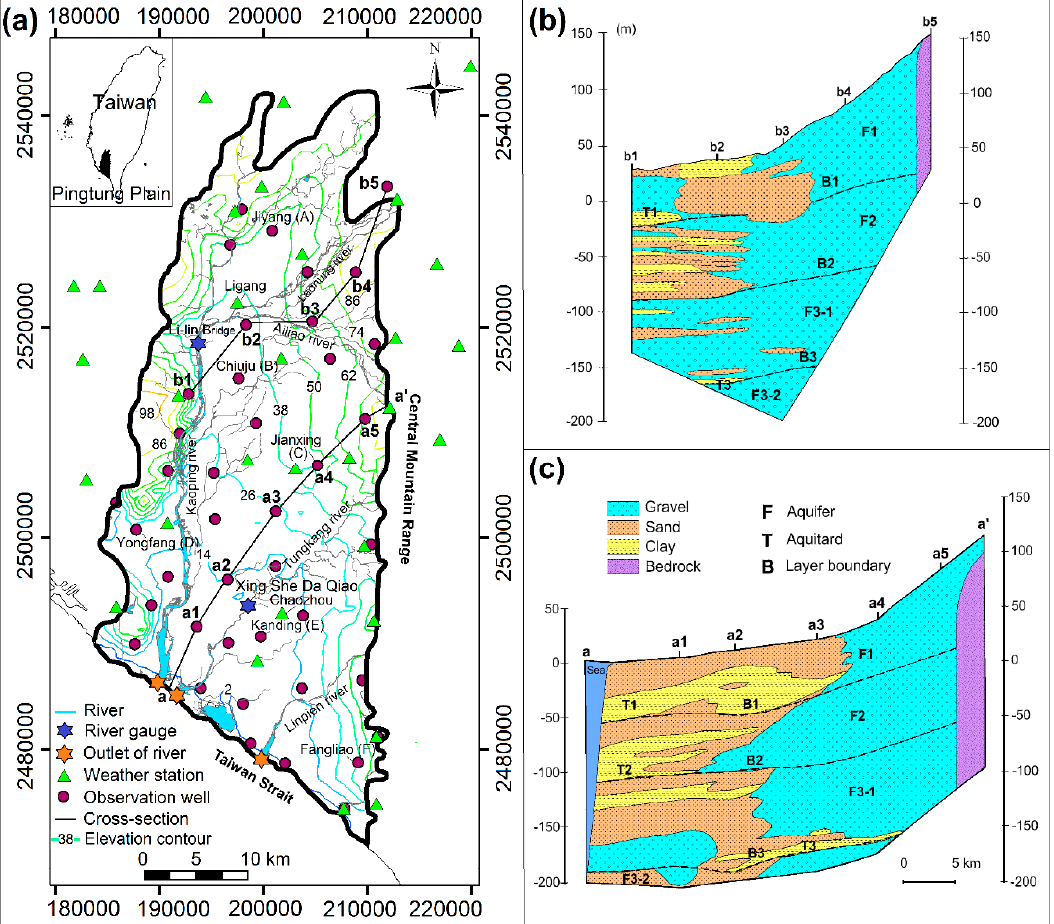
Figure 1. The study area and the selected hydrogeological profiles: ( a ) the Pingtung Plain groundwater basin (PPGB) and the monitoring stations for surface water and groundwater, ( b ) the geological profile for cross-section b1-b5, and ( c ) the geological profile for cross-section a-a’. Note that the area in the upstream of the confluence point (i.e., Li-lin Bridge) of the Kaoping river, Ailiao, and Laonung rivers was defined as the upstream fan in the study. The downstream area of the Kaoping river and Tungkang and Linpien rivers was defined as the downstream fan.